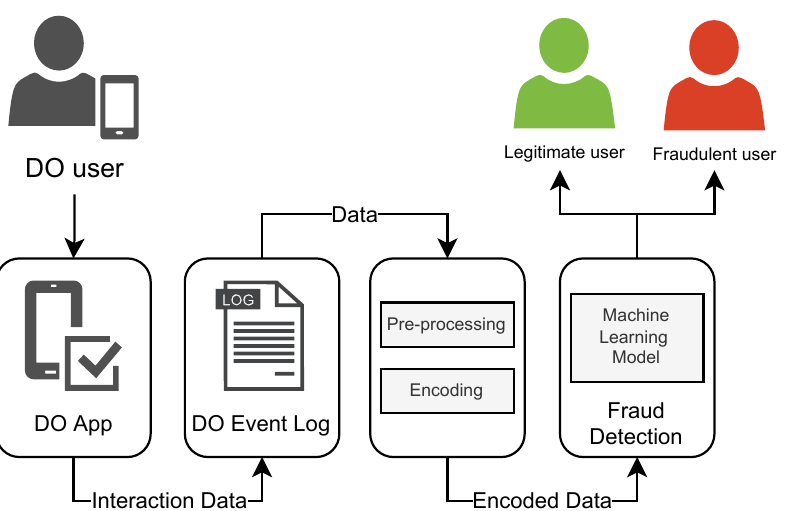
Figure 1. Proposed approach overview, from DO user’s interaction to PM classification of user